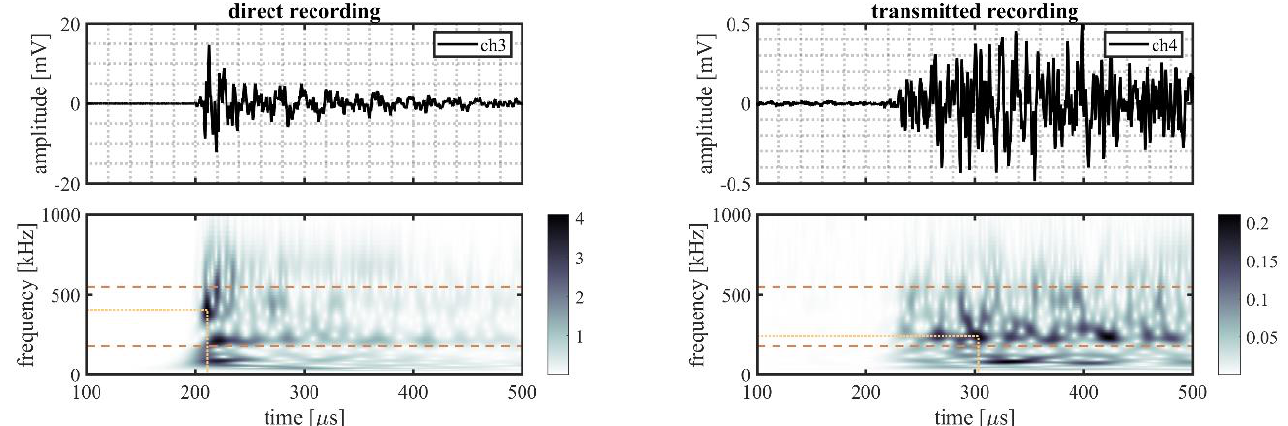
Figure 7. Randomly selected event recorded by WDI-AST sensors, originating from a source location S22, showing: the time traces recorded on the outer raceway (ch3, top left ) and on the inner raceway (ch4, top right ), and the time – frequency representation of the recorded signals on the outer ( bottom left ) and the inner ( bottom right ) raceways. The detected magnitude in the time–frequency representations of the signals is indicated by the intersection of the dotted lines; the dashed lines indicate the frequency range of interest (180 – 550 kHz).